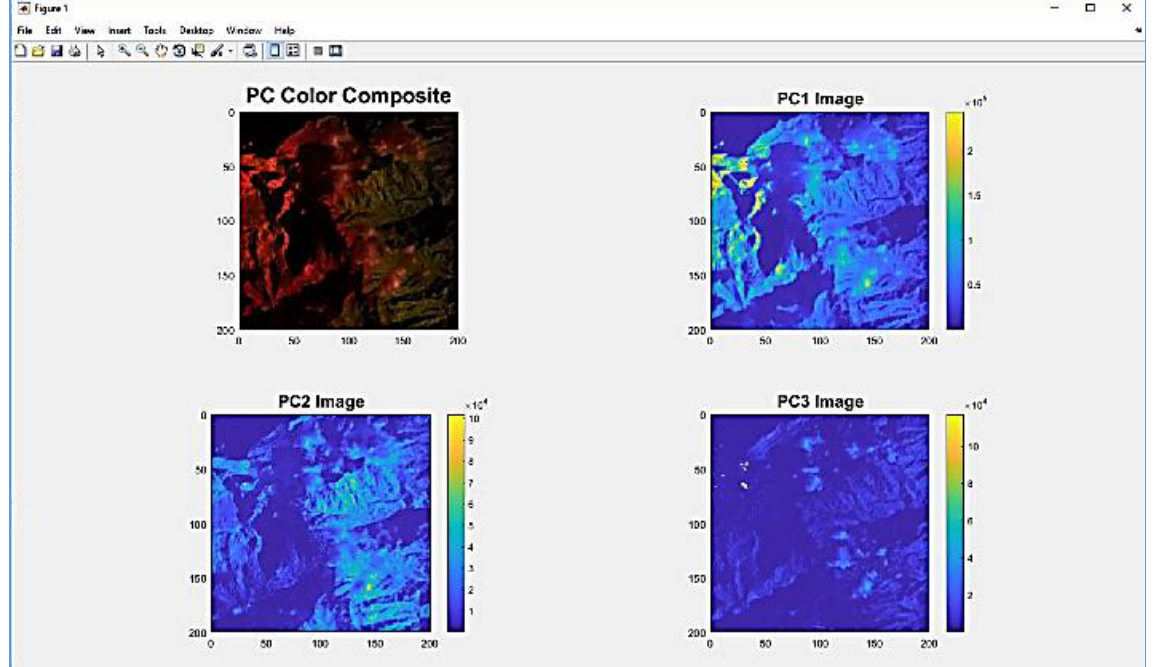
Figure 9. Example of the PCA result from the interface shown in Figure